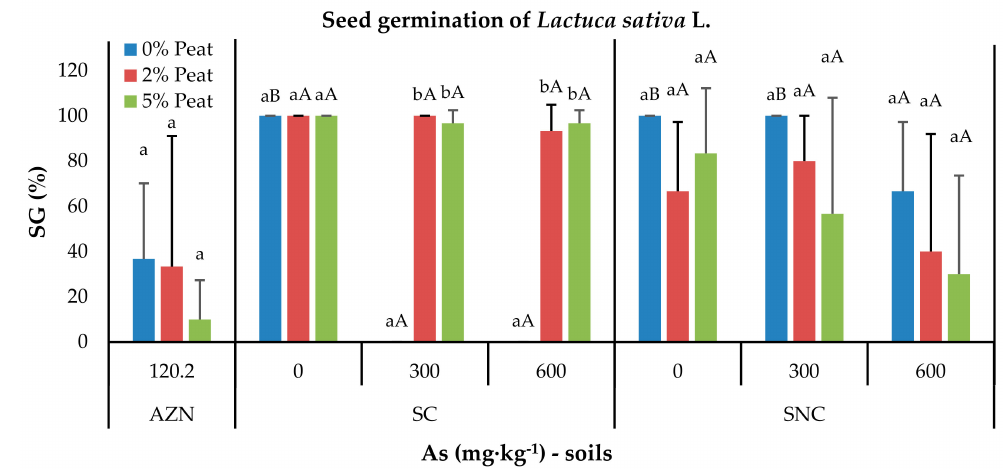
Figure 2. Percentage of germination for Lactuca sativa L. seeds (SG%) exposed to the di ff erent soils and treatments. Lowercase letters indicate statistically significant di ff erences for each treatment with di ff erent peat additions; and capital letters among the di ff erent treatments with As for the same peat content (Kruskal-Wallis test, p <